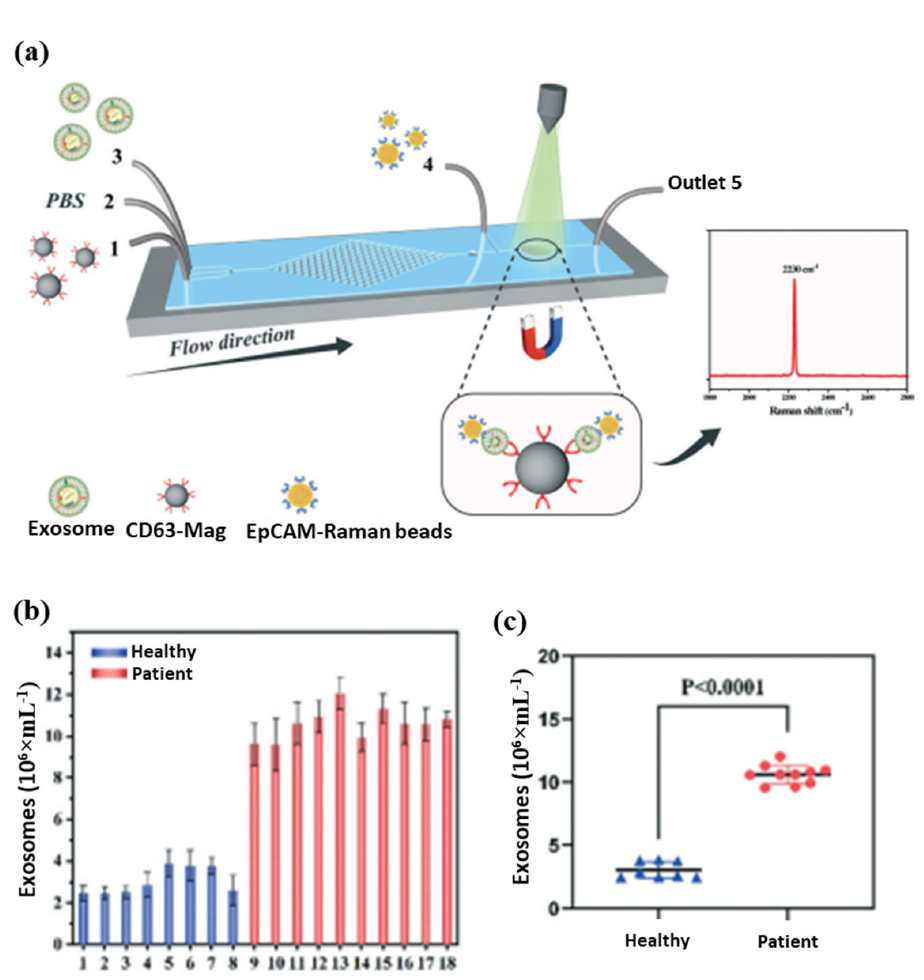
Figure 6. ( a ) Schematic diagram of exosome detection and capture using a microfluidic Raman chip, ( b ) detection of exosomes in clinical serum directly using a microfluidic Raman chip, and ( c ) analysis of clinical samples using dot plots [154].